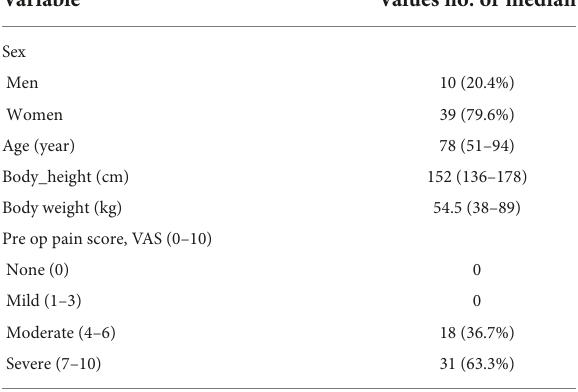
TABLE 1 Patient demographics and clinical status of vertebral compression fractures in 49 patients. Variable Values no. or